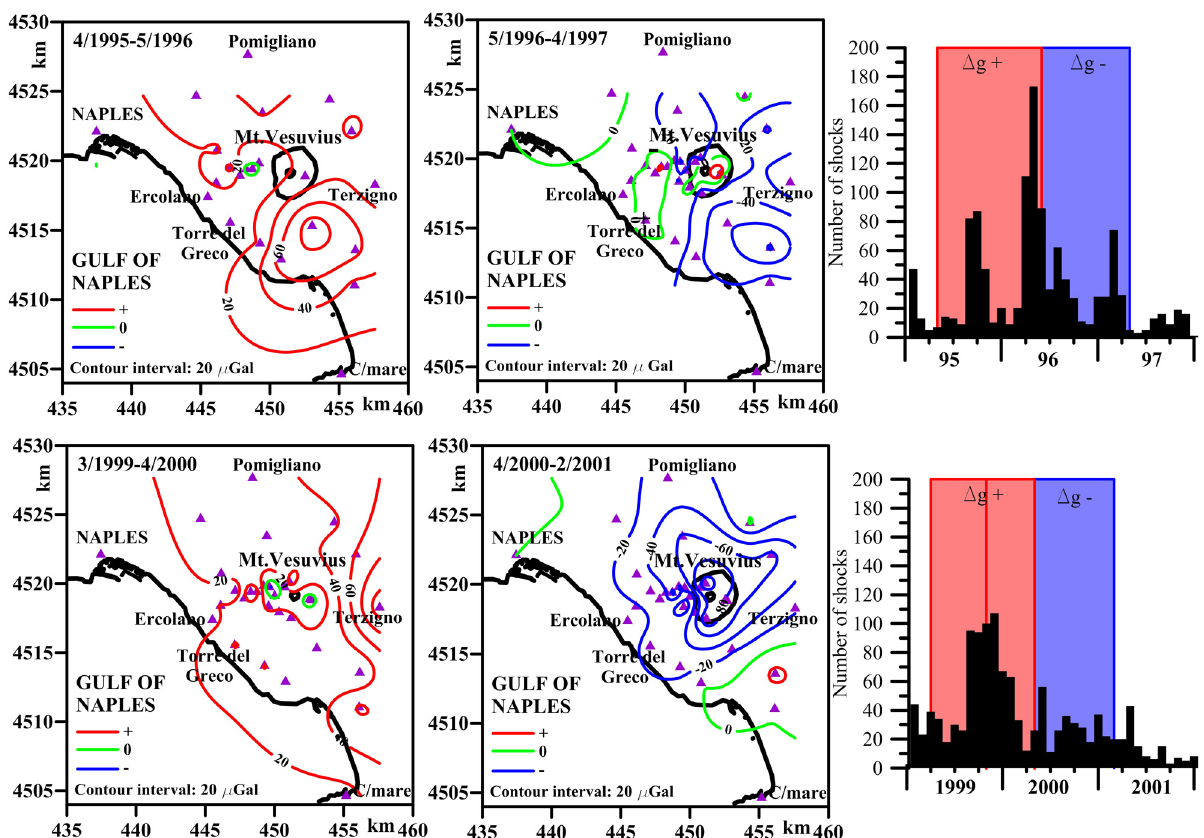
Figure 4. The few significant gravity changes fields over short time intervals overlapping the most recent seismic crises: 1995-1996 (up) and 1999-2000 (down). In both cases a gravity increase anticipates and overlaps the seismic crisis (see graphics on the right) and is soon after fol- lowed by a gravity decrease. Graphics on the right show the number of earthquakes during the analyzed time interval; on them the length of both increasing and decreasing periods are respectively highlighted in red and in blue. The intermediate red line, in the red part of the graphic on the right related to 1999-2000 interval, indicates the date of an additional field survey (October